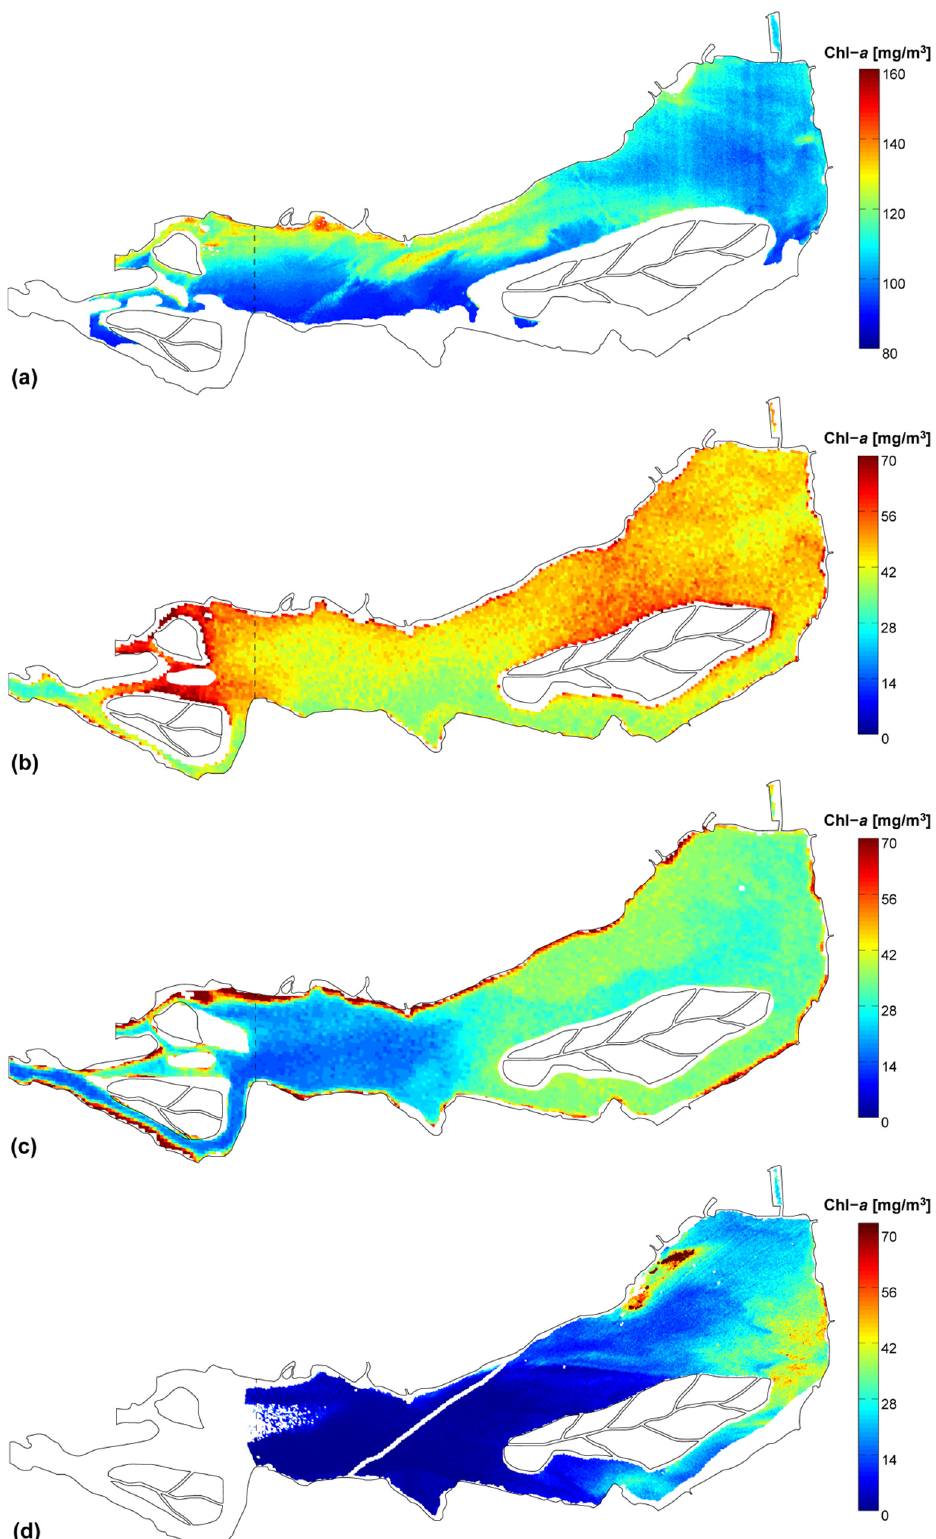
Figure 2. Chlorophyll- a (Chl- a ) distribution maps for the MIVIS 26 July 2007 ( a ); CHRIS-PROBA 29 June 2008 ( b ); CHRIS-PROBA 28 August 2011 ( c ) and APEX 21 September 2011 ( d )